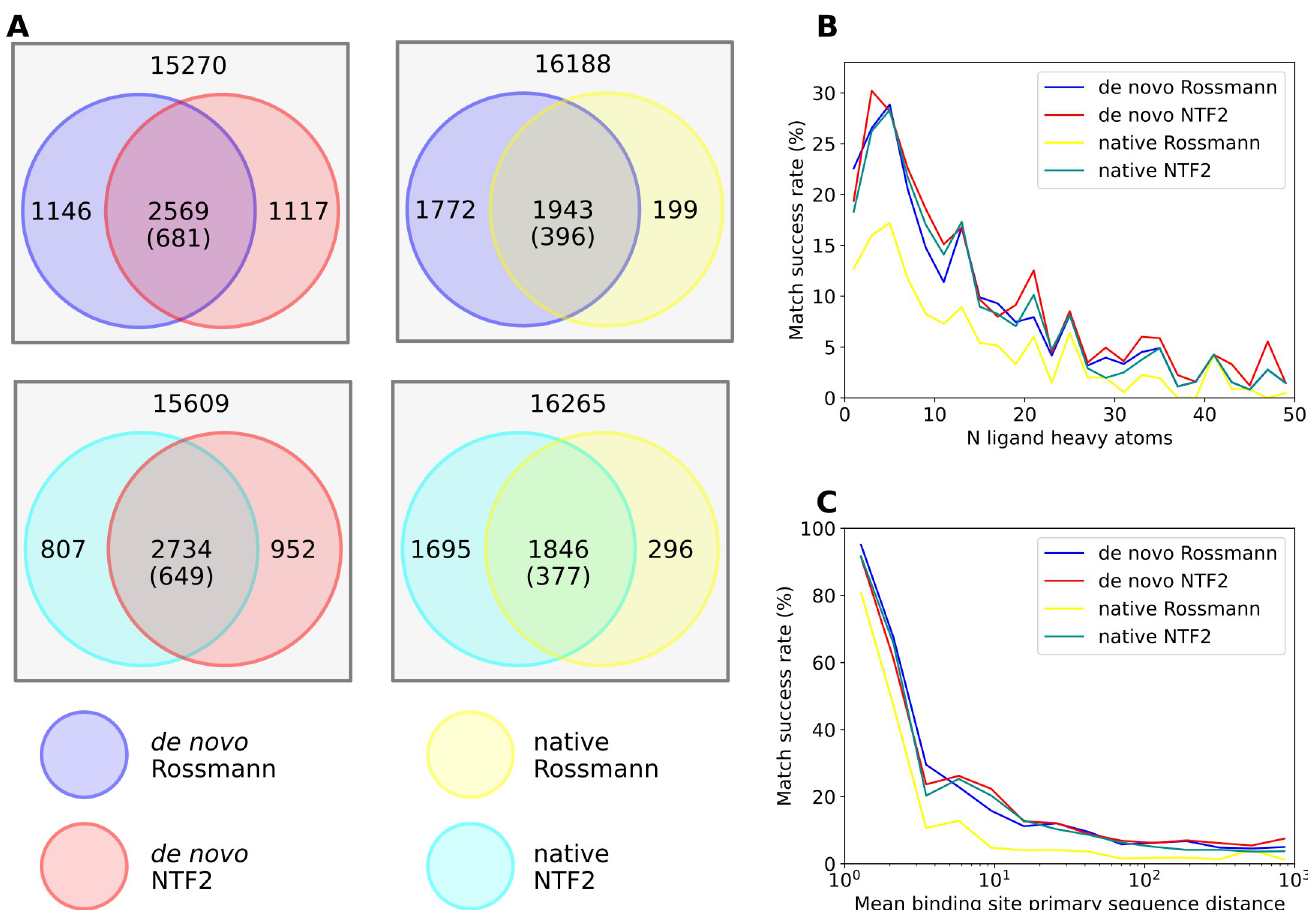
Fig 5. Features affecting matching success rates of 3-residue ligand binding sites. A. Venn diagrams of the number of Rosetta-matched 3-residue binding sites between pairs of scaffold sets. The number in the overlapping region is the observed number of binding sites that can be matched to both scaffold sets, with the expected number in parentheses. The number in the non-overlapping region within a circle denotes the binding sites that can only be matched to this scaffold set. The number outside the circles denotes the binding sites that cannot be matched to either of the two scaffold sets. B. The numbers of ligand heavy atoms are negatively correlated with the match success rates. C. The mean primary sequence distances between binding site residues are negatively correlated with match success rates.